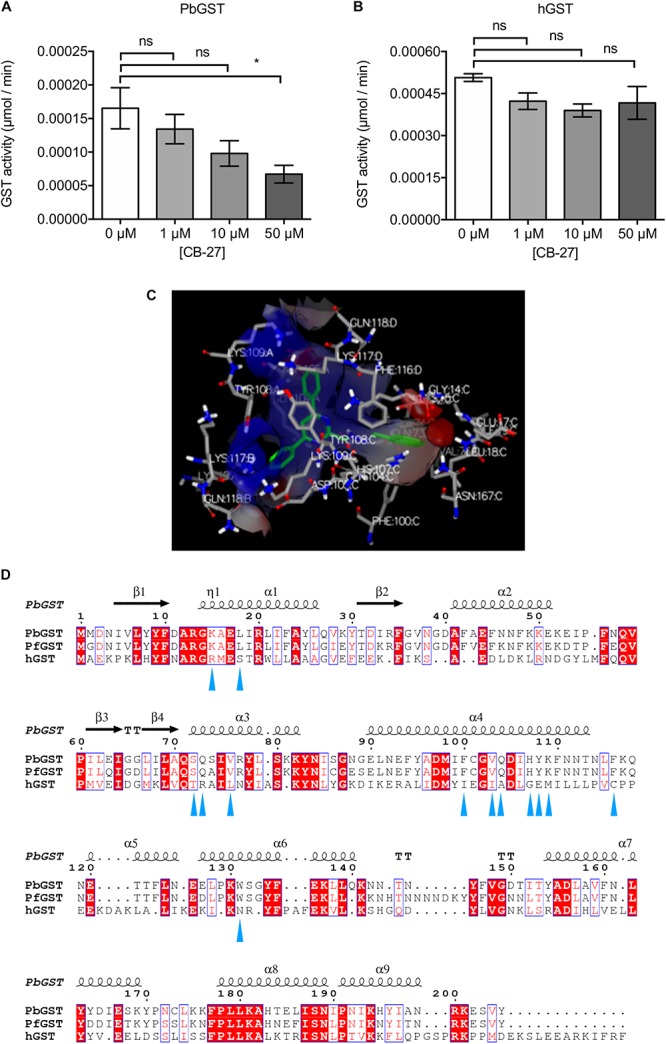
Inhibition of PbGST by CB-27 and proposed binding mode. GST inhibition by CB-27 was determined at three different concentrations (1, 10, and 50 μM) in: (A) crude P. berghei protein extracts from blood stages, and (B) human placenta GST. Data are means ± SEM and represents four independent experiments. PbGST activity was significantly reduced at 50 μM (∗p < 0.0418), analyzed by One-Way ANOVA with Bonferroni’s multiple comparisons test. (C) Predicted binding mode and interactions of CB-27 in the PbGST H-site. The structure of the PbGST is shown as a silhouette with the binding site displayed as a surface representation. CB-27 is represented as sticks with carbon (green), and nitrogen (blue). The amino acids of the protein are represented as sticks with carbon (gray), hydrogen (white), nitrogen (blue), and oxygen (red). Amino acid residues interacting in the proximity of the compounds are displayed with three-letter code, and the number represents the position in the polypeptide. (D) Structure-based sequence alignment of PbGST, PfGST, and hGST. Key residues interacting with CB-27 are highlighted with blue triangles below the sequence.